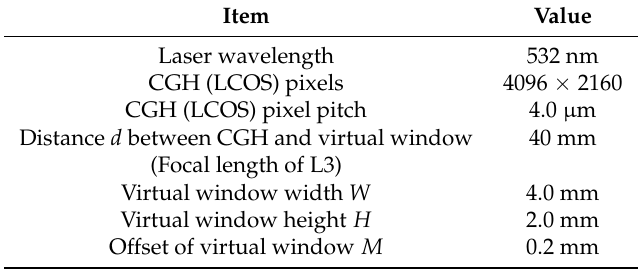
Table 1. Simulation parameters based on the volume hologram printer.